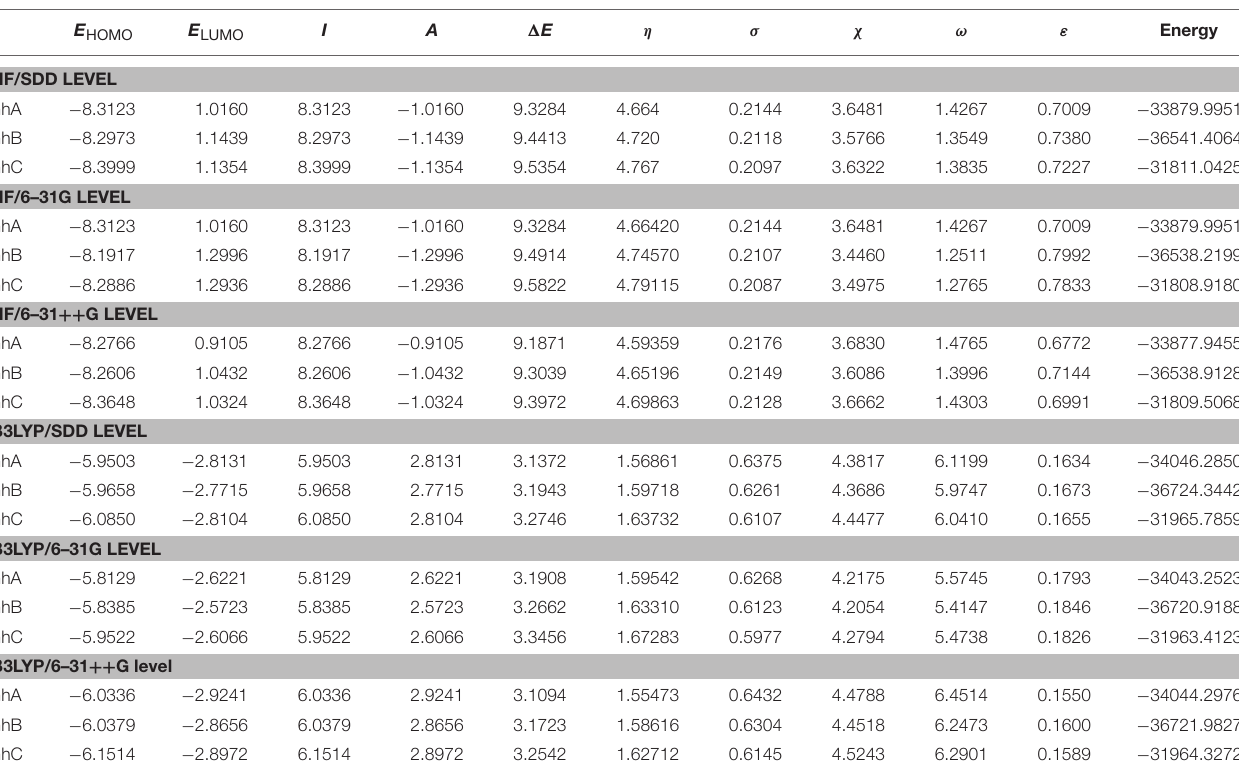
TABLE 2 | Calculated quantum chemical parameters for three thiophene derivatives in aqueous phase (all in eV). E